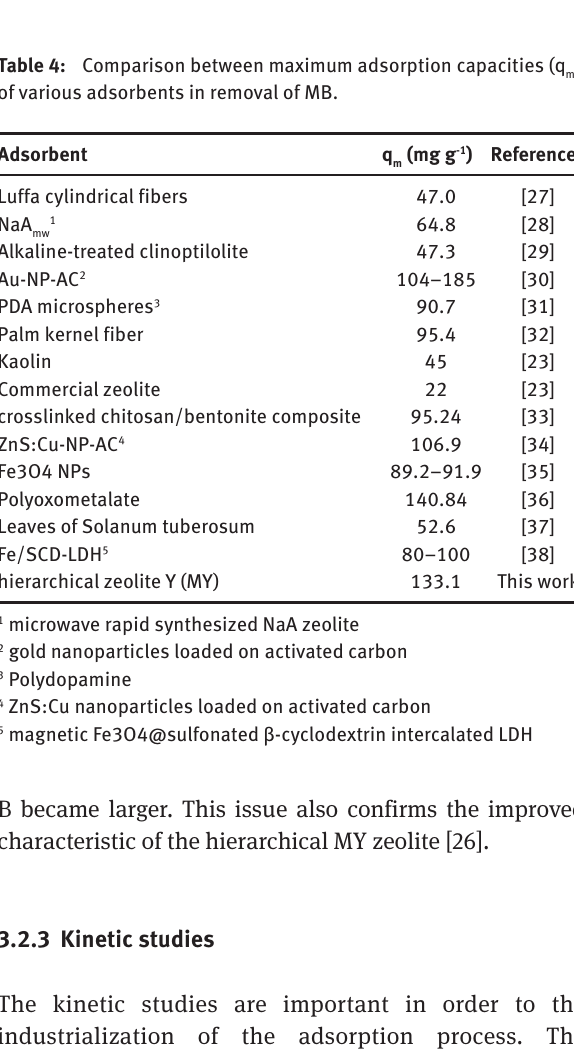
Figure 9: Equilibrium adsorption isotherms of methylene blue on (a) microporous NaY and (b) hierarchical MY.